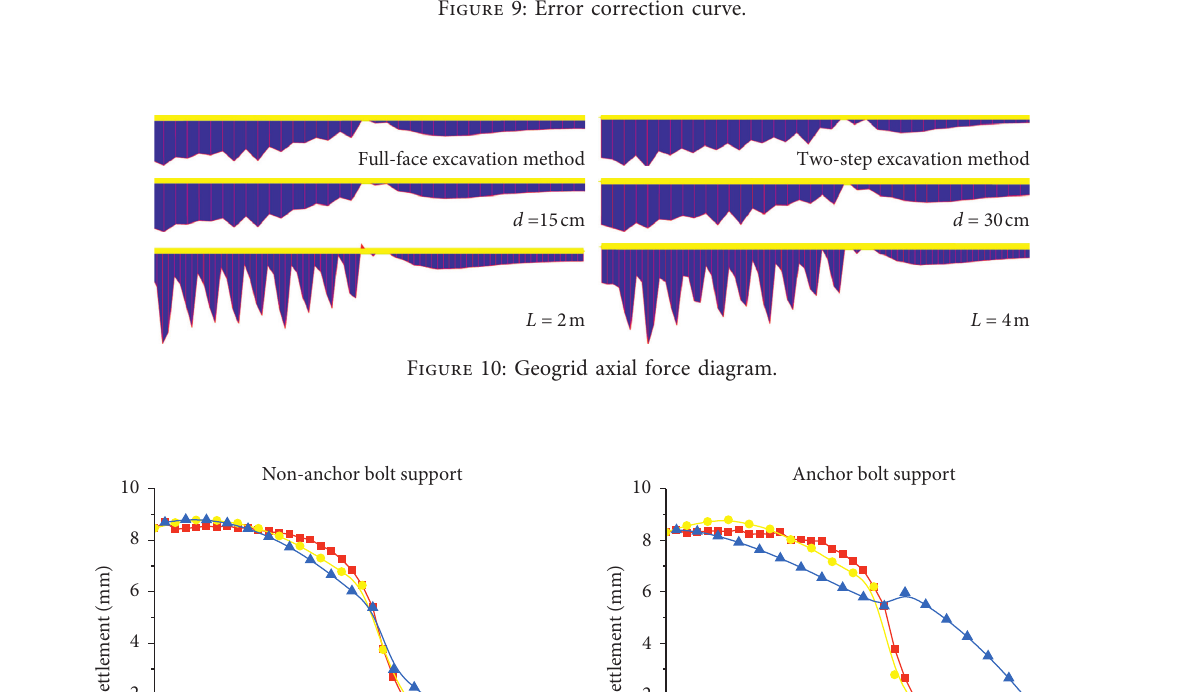
Figure 9: Error correction curve.